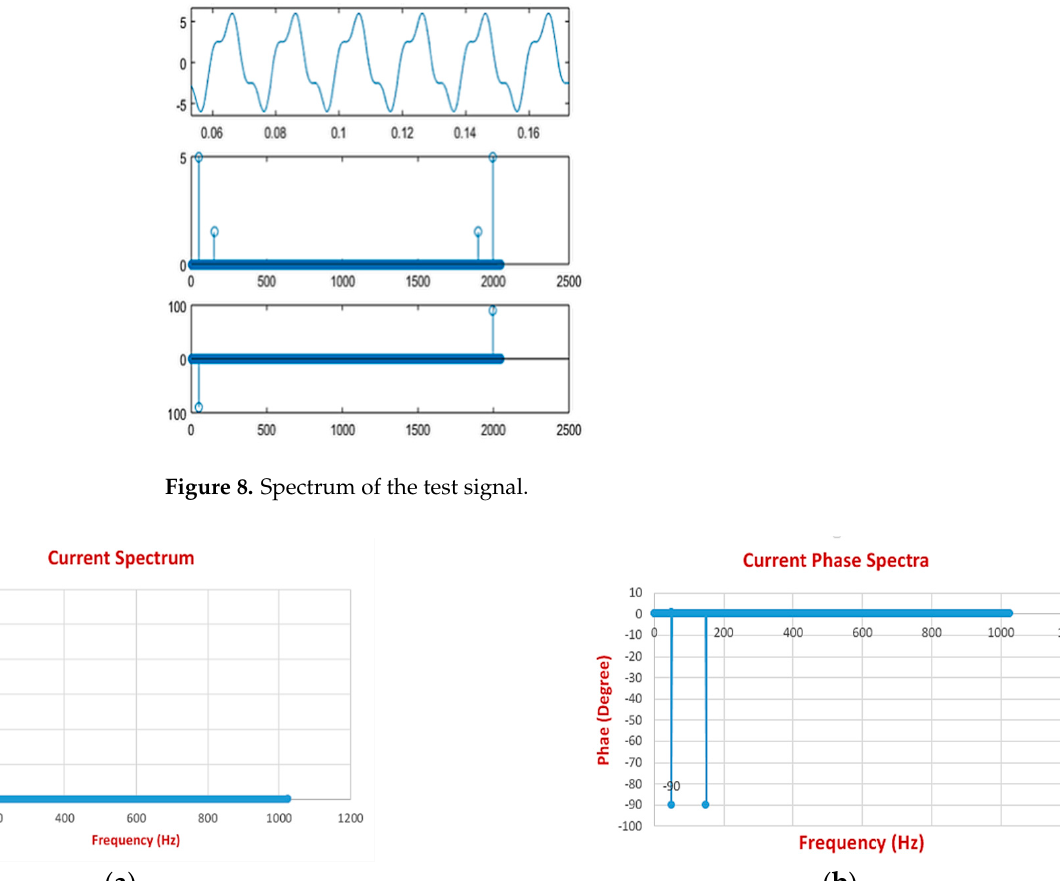
Figure 7. Interrupt generation.